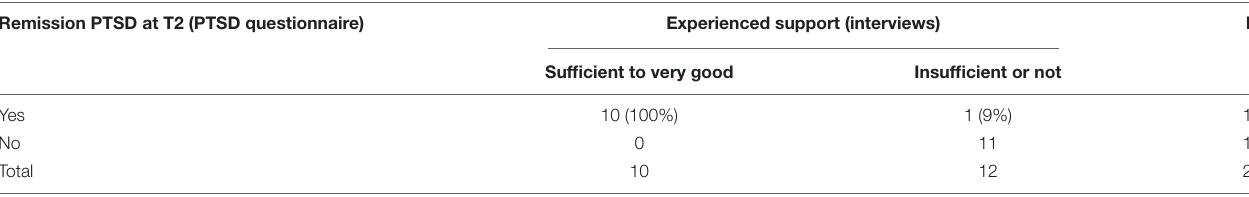
TABLE 4 | Association between experienced support during NET and remission of PTSD. Remission PTSD at T2 (PTSD